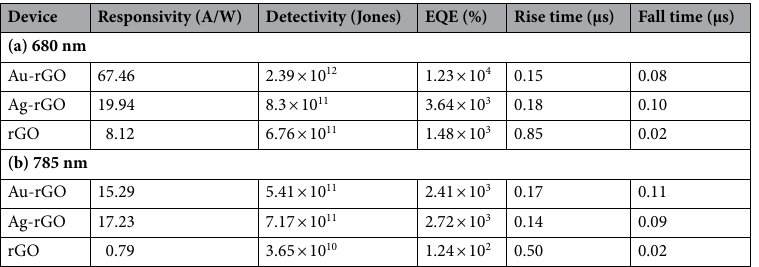
Table 1. Summary of the figure of merit of all three devices; Au NPs-rGO, Ag NPs-rGO and rGO under wavelength of (a) 680 nm and (b) 785